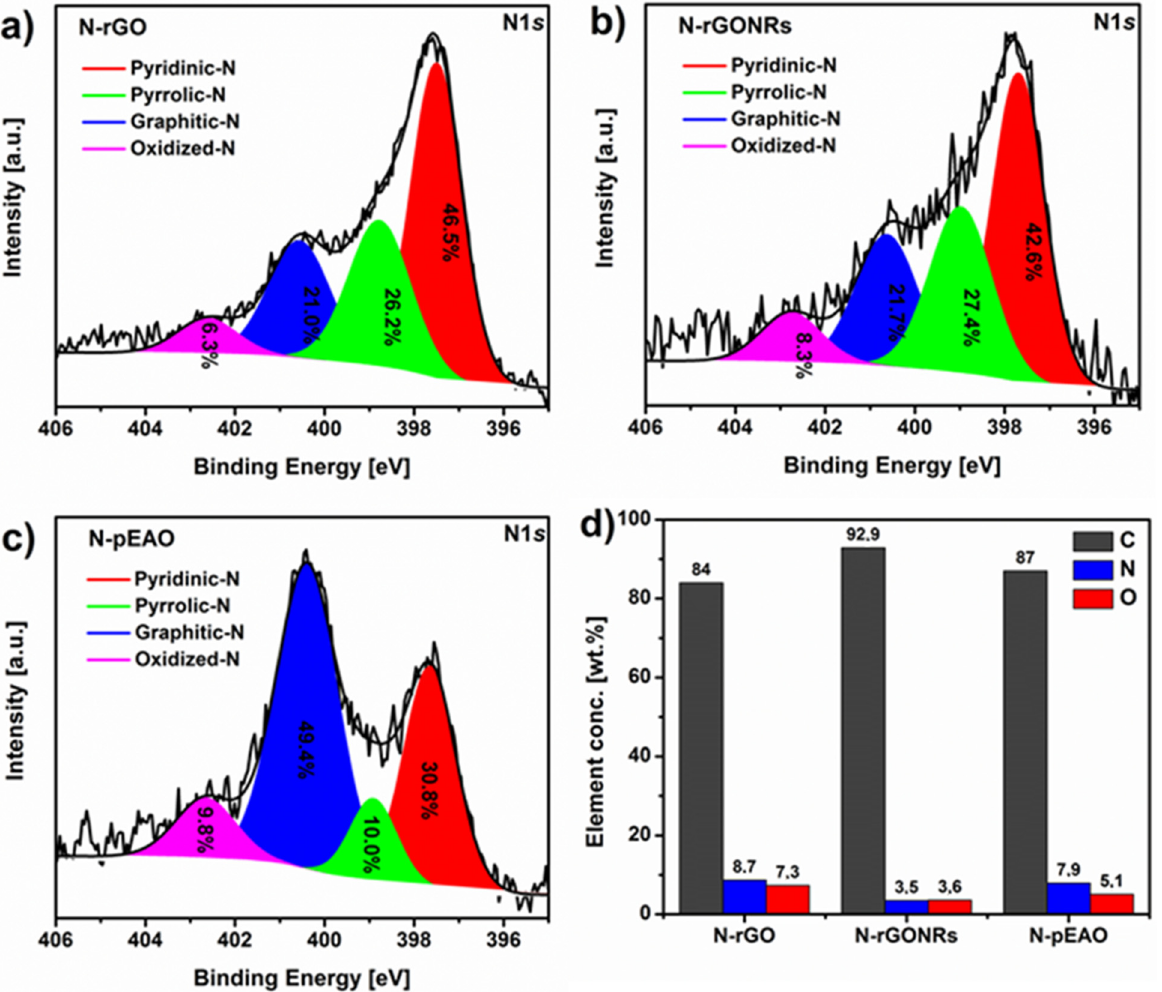
Figure 2. N1s XPS core level spectra with spectral deconvolution and quantified values for ( a ) N-rGO, ( b ) N-rGONRs, and ( c ) N-pEAO, and ( d ) Corresponding quantified values of C, N, and O from the XPS survey spectra.